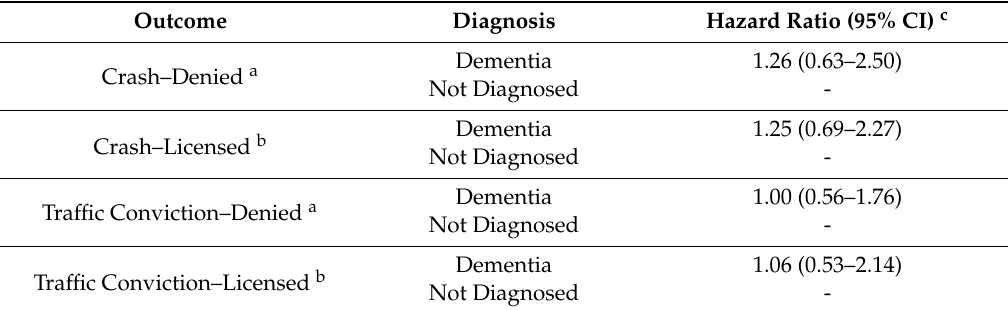
Table 4. Hazard ratios for crash and conviction post license